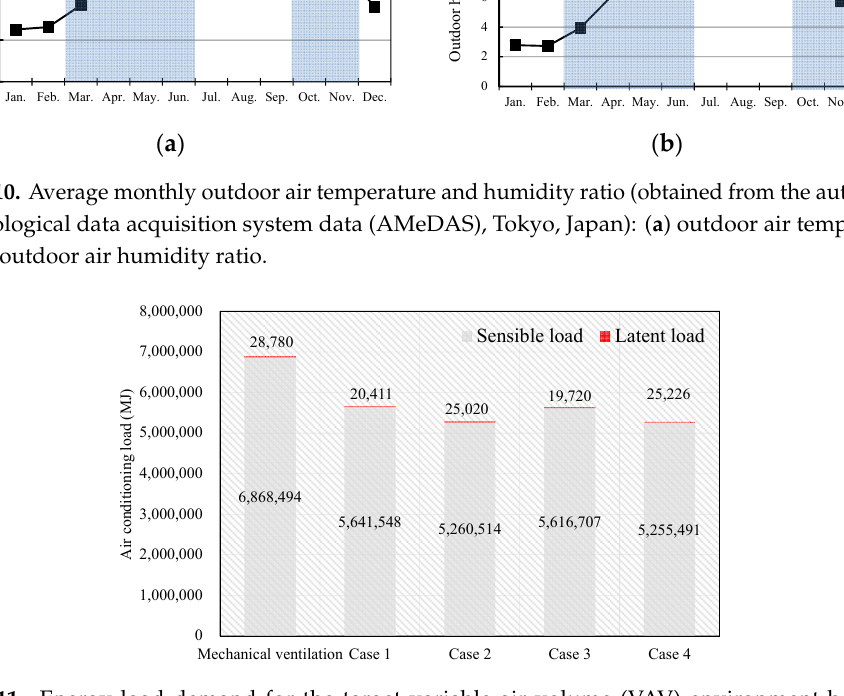
Figure 11. Energy load demand for the target variable air volume (VAV) environment based on comparisons between mechanical ventilation and window opening (natural ventilation).